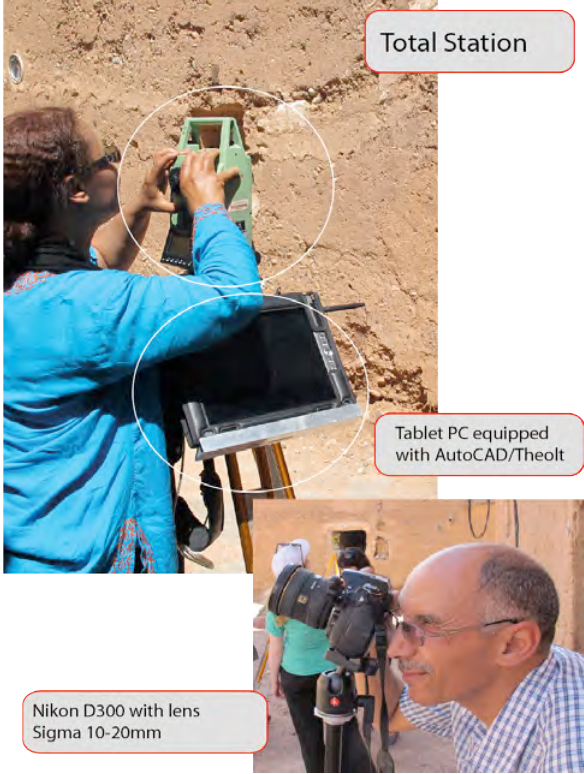
Figure 2: EDM surveying